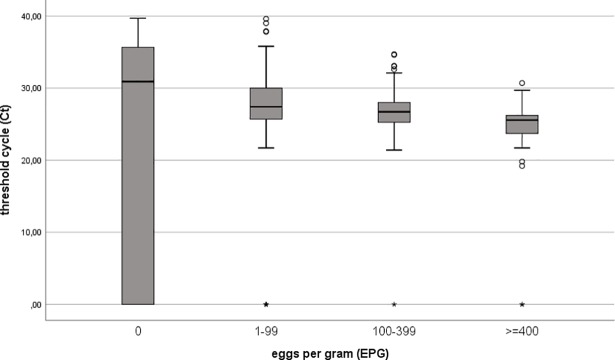
Threshold cycle (Ct) values of S. mansoni specific real-time PCR correlate negatively with the level of schistosome infection (determined by the Kato Katz method, expressed in eggs per gram (EPG)) (Spearman's correlation coefficient = -0.32; p < 0.001).S. mansoni real-time PCR-positive samples show a decreasing Ct value with increasing egg count category.